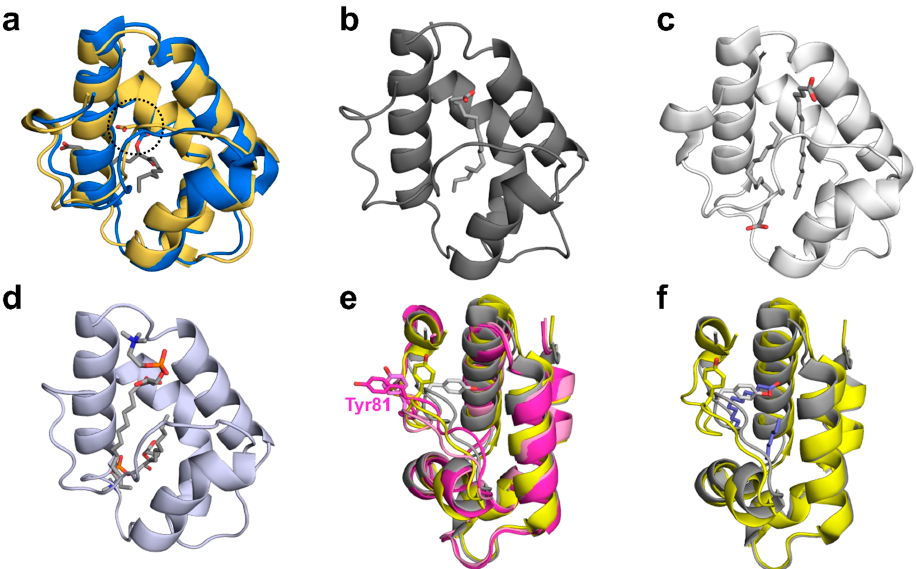
Figure 5. Lipid binding modes observed in nsLTPs. ( a ) Covalent binding of oxylipin by barley nsLTP (PDB code: 3GSH). Model of barley nsLTP is shown in blue. Structure of Act c 10.0101 is shown in gold. Asp7 (barley), Asp8 (Act c 10.0101), and oxylipin are shown in stick representation. Position of the conserved Asp is marked with a circle. ( b ) Complex of maize nsLTP with α -linolenic acid (PDB code: 1FK6). ( c ) Complex of rice nsLTP with two molecules of palmitoleic acid (PDB code: 1UVB). ( d ) Complex of wheat nsLTP with two molecules of lyso-myristoyl-phosphatidylcholine (PDB code: 1BWO). ( e ) Superposition of Cor a 8 (PDB code: 4XUW; grey), Pru p 3 (PDB code: 2ALG; yellow), and models corresponding to two different conformations of Pun g 1.0101 (pink). Conserved Tyr81 is shown in stick representation. ( f ) Superposition of Cor a 8 and Pru p 3. Lipids bound by Pru p 3 are shown in purple. The figure shows that the conformation of the conserved residues that is present in the Cor a 8 structure is not compatible with ligand binding.